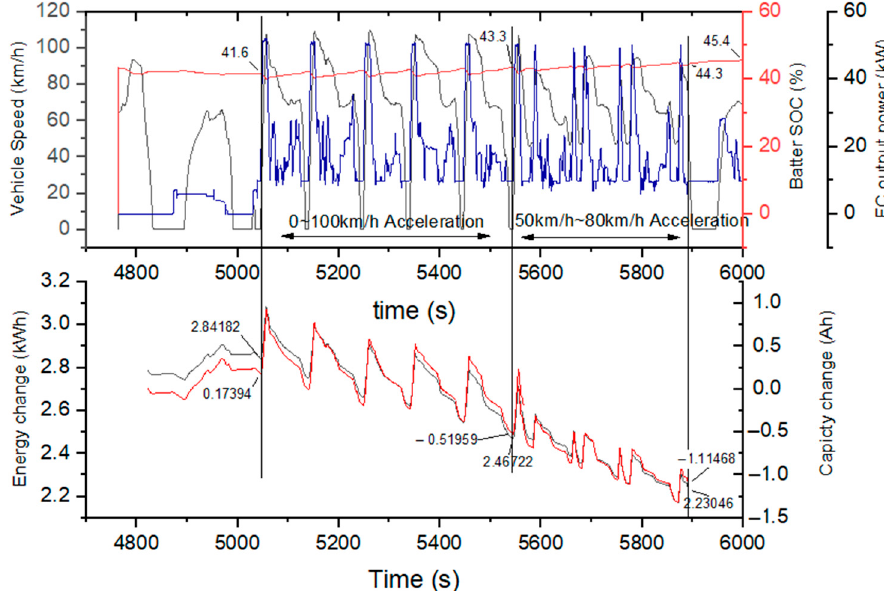
Figure 11. Acceleration test data.